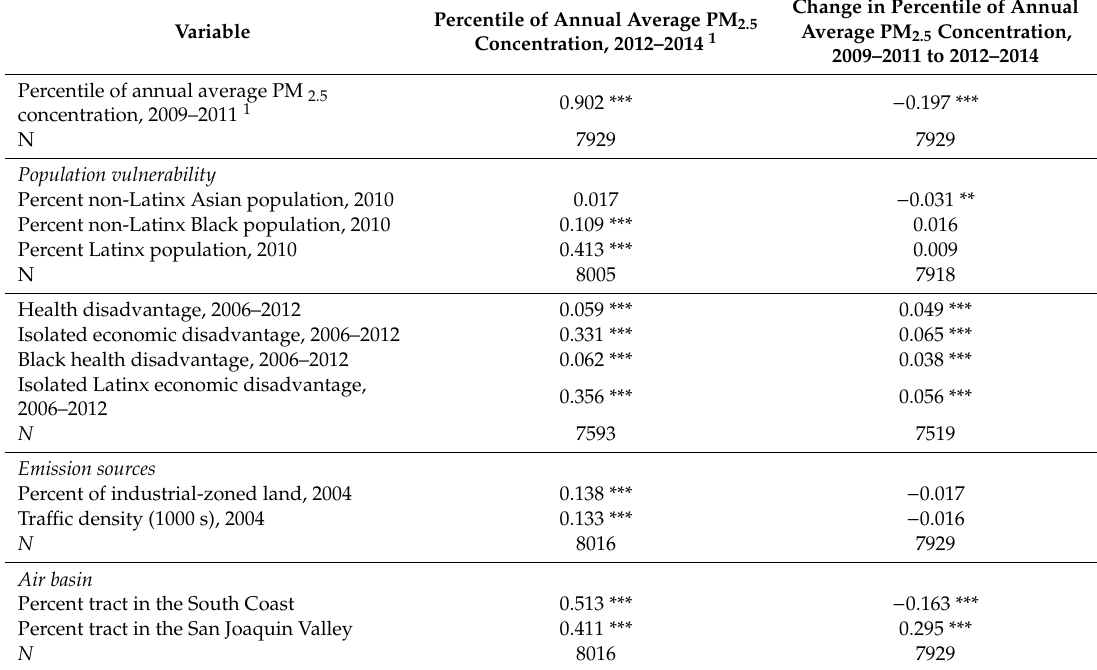
Table A2. Pearson correlation coe ffi cients measuring associations between percentile rankings of annual average PM 2.5 concentrations in 2012–2014 and change in percentile rankings of annual average PM 2.5 concentrations from 2009–2011 to 2012–2014 and variables included in the spatial lag regression analyses. Change in Percentile of Annual Percentile of Annual Average PM 2.5 Variable Average PM 2.5 Concentration, Concentration, 2012–2014 1 2009–2011 to 2012–2014 Percentile of annual average PM 2.5 concentration, 2009–2011